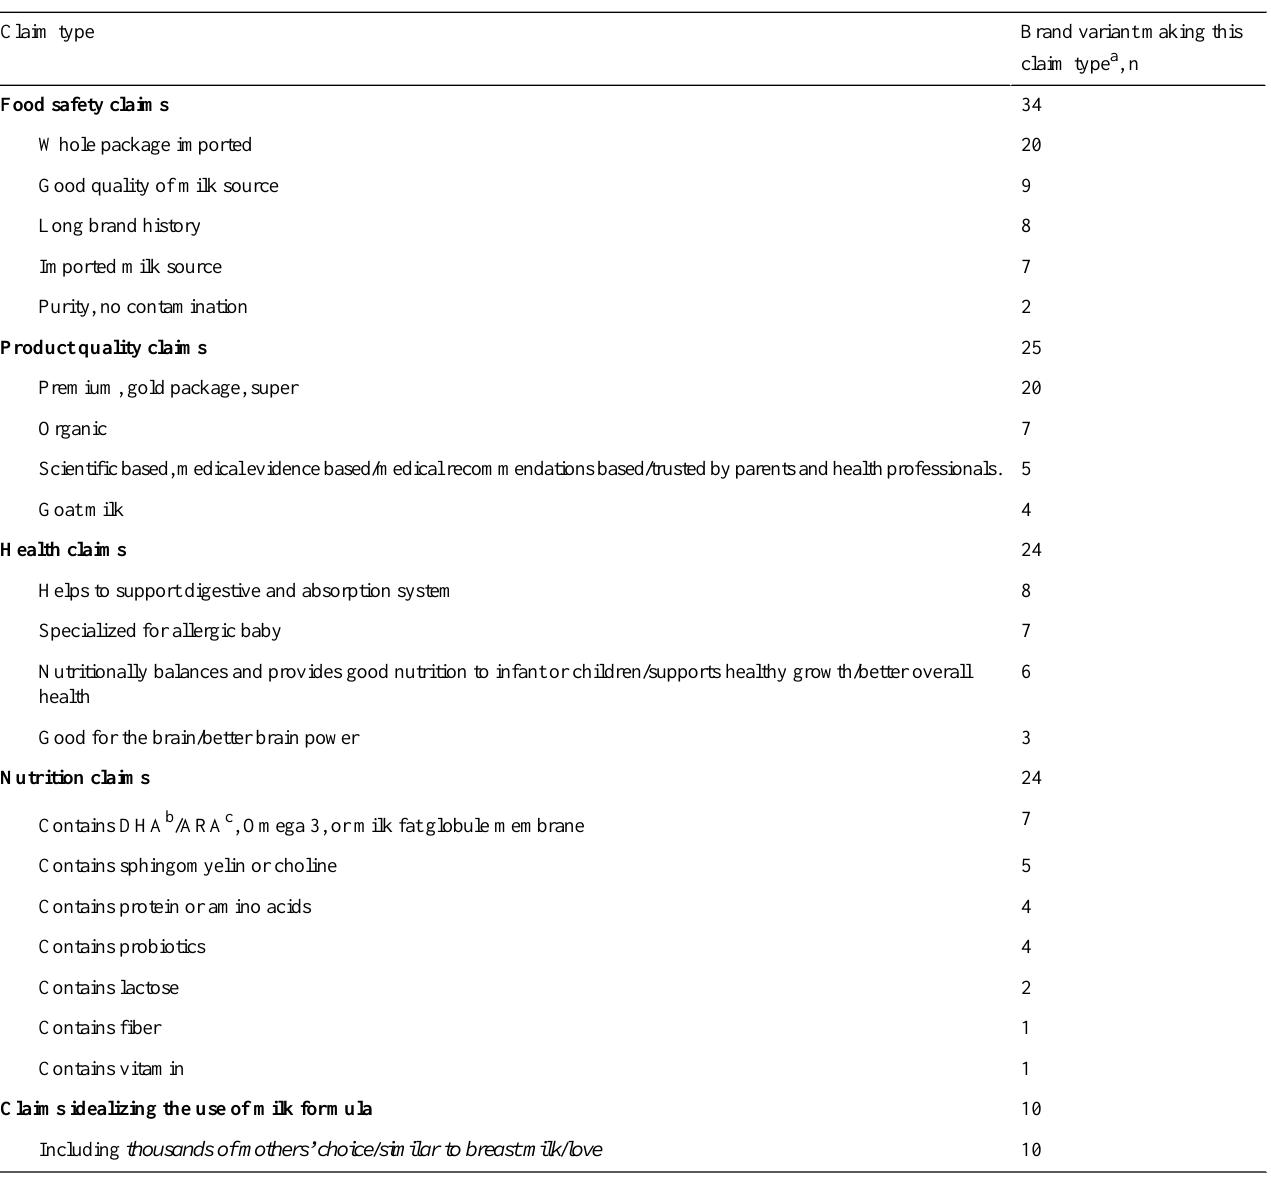
Table 3. Prevalence of 79 milk formula brand variants making claims by type of